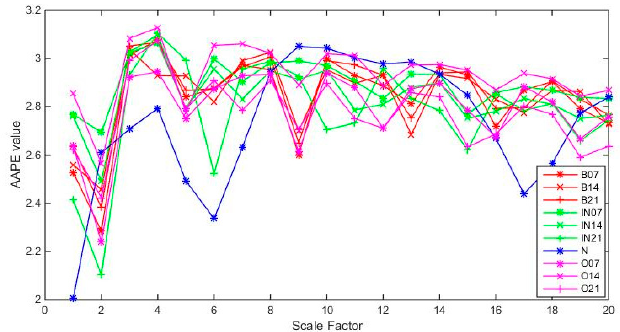
Figure 10. IMAAPE feature vectors for different fault types under different fault diameters with the load 0 hp.